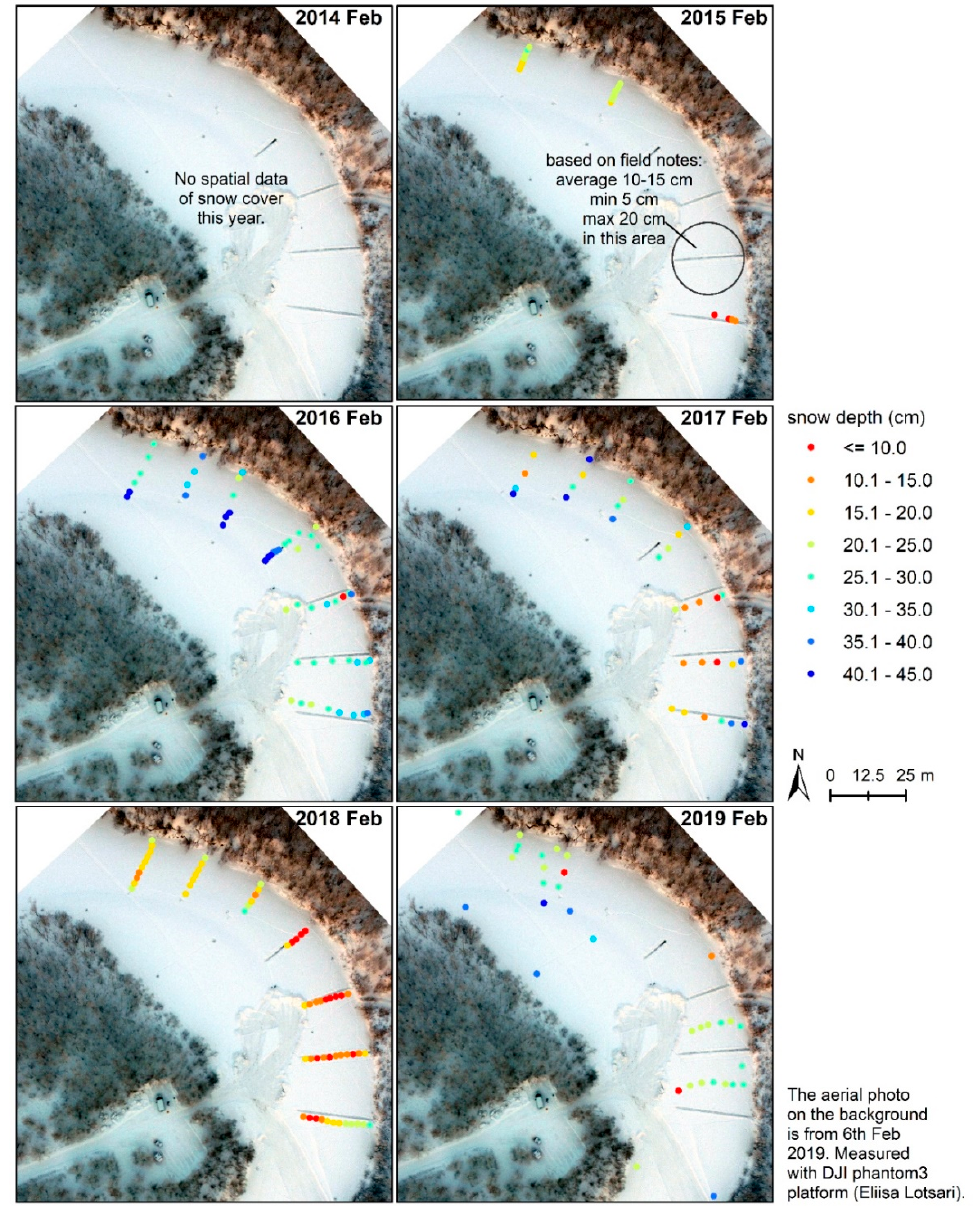
Figure 10. The snow depth variation in the Pulmanki study site during the mid-winter measurements. Least snow was present on the river ice during winters 2014 and 2018.